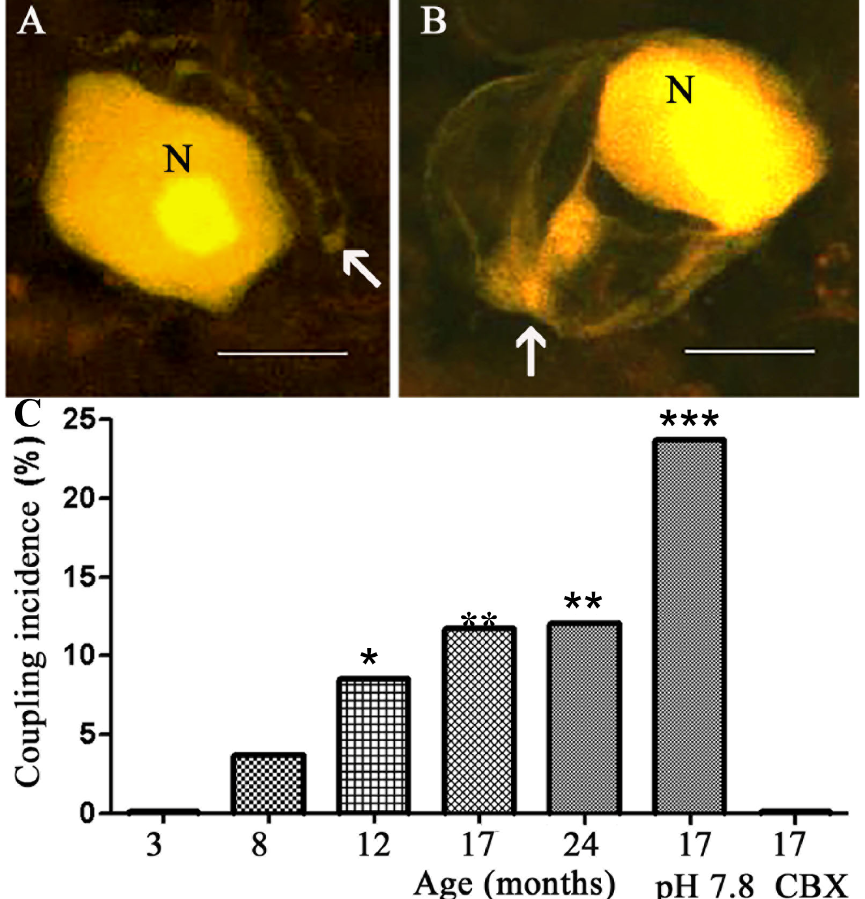
Figure 1. Confocal microscope images of LY-injected neurons in mouse DRGs. ( A ) A neuron (N) with its axon (arrow) in a ganglion from a 3 Mo old mouse is not coupled to SGCs. ( B ) In a ganglion from a 12 Mo mouse, a dye-injected neuron is coupled to SGCs (arrow) surrounding two adjacent neurons. Scale bars, 20 µ m. ( C ) Summary of the dye-coupling results. Coupling between neurons and SGCs was observed only in the ganglia from aged mice (8, 12, 17, and 24 Mo). This effect was enhanced when the ganglia were bathed at a slightly basic pH 7.8, and was reduced by the gap junction blocker carbenoxolone (CBX, 50 µ M), consistent with gap junction-mediated coupling. The number of cells per data point is 103–164 (72 for CBX results). ANOVA was used for comparison (see Section 4); * p < 0.05, ** p < 0.01, *** p < 0.0001, compared with the control (3 Mo).